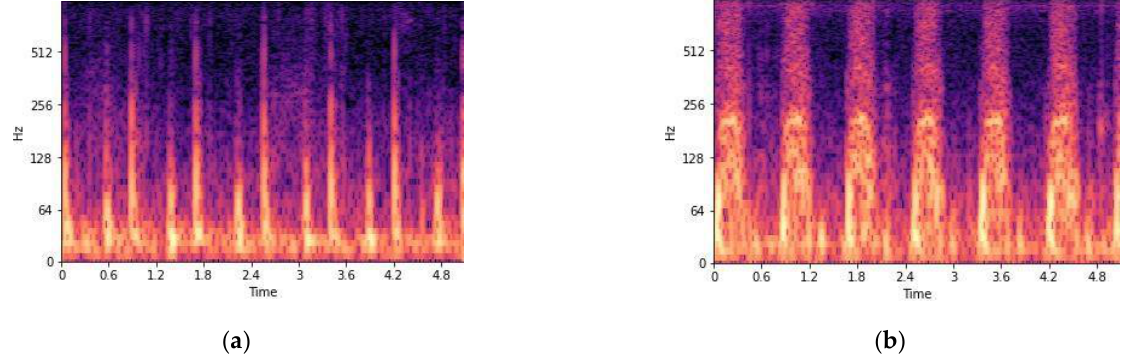
Figure 6. ( a ) Normal heartbeat spectrogram and ( b ) abnormal heartbeat spectrogram.